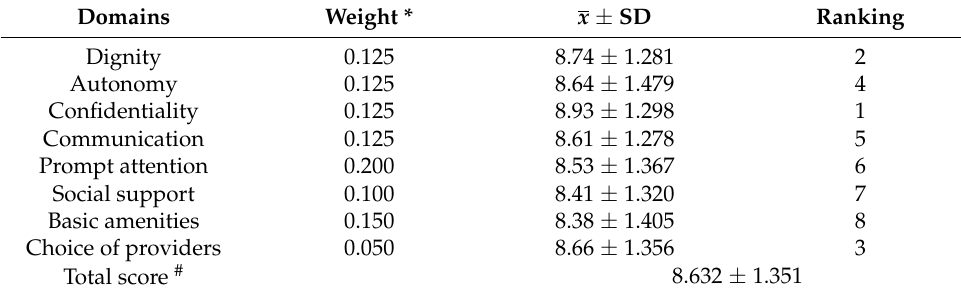
Table 3. Scores of level of patients-perceived HSR.